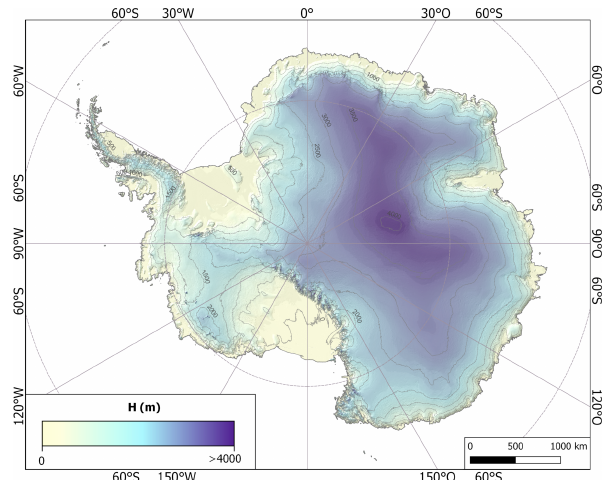
Figure 9. Gap-filled and edited TanDEM-X PolarDEM 90m of Antarctica in color-coded